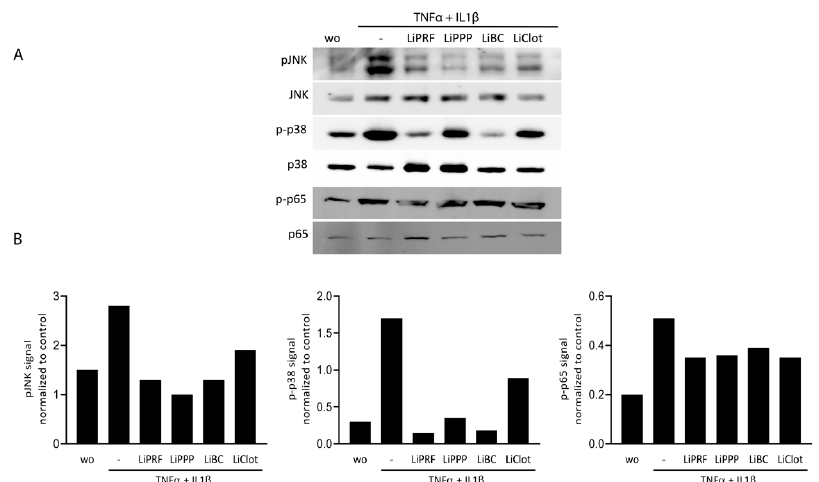
Figure 4. Lipid extracts isolated from PRF and blood reduced phosphorylation of MAP kinases and p65 in ST2 cells. ST2 cells were treated with TNF α and IL1 β in the presence or absence of 20% LiPRF, LiPPP, LiBC and LiClot. ( A ) Western blot analysis was carried out for phospho-JNK, -p38, -p65 and total JNK, p38 and p65. ( B ) Western blot signal intensity was quantified for phospho-JNK, -p38, and -p65 compared to total JNK, p38 and p65. WO means without and represents unstimulated cells. Western blot is representative for 2 independent experiments. N = 2.